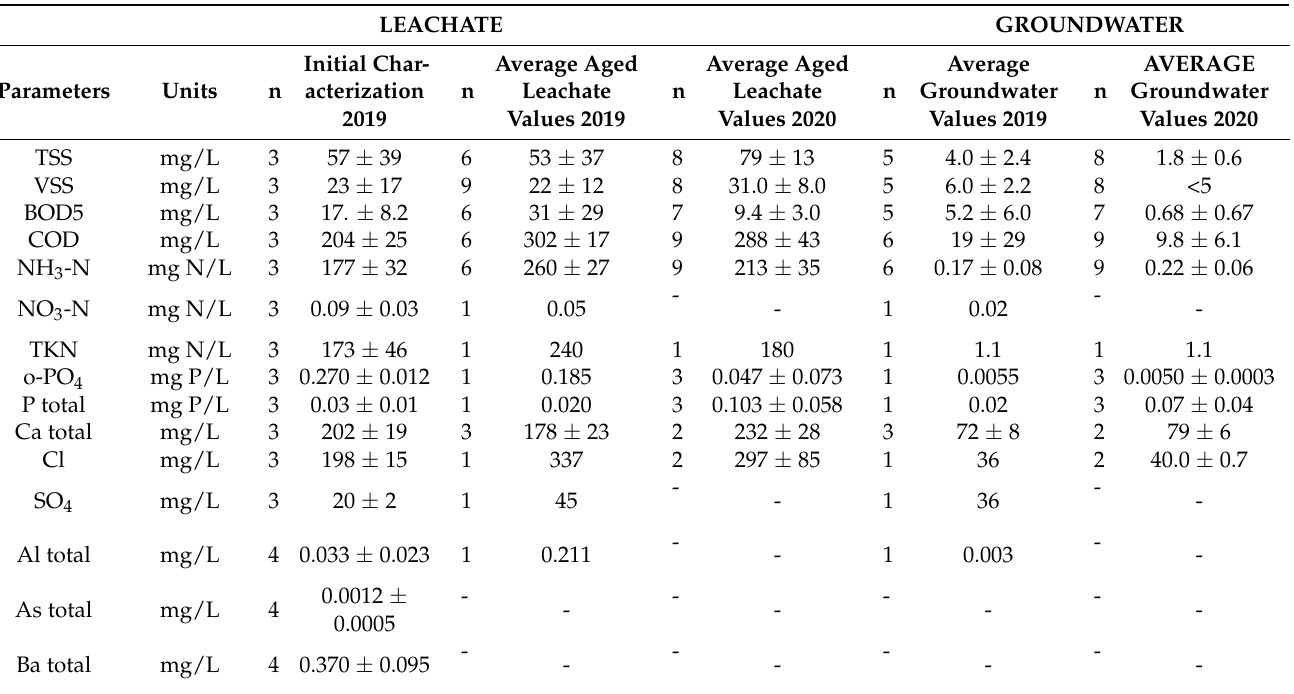
Table 6. Physicochemical properties of aged leachate and groundwater used for the irrigation of willows in 2019 and